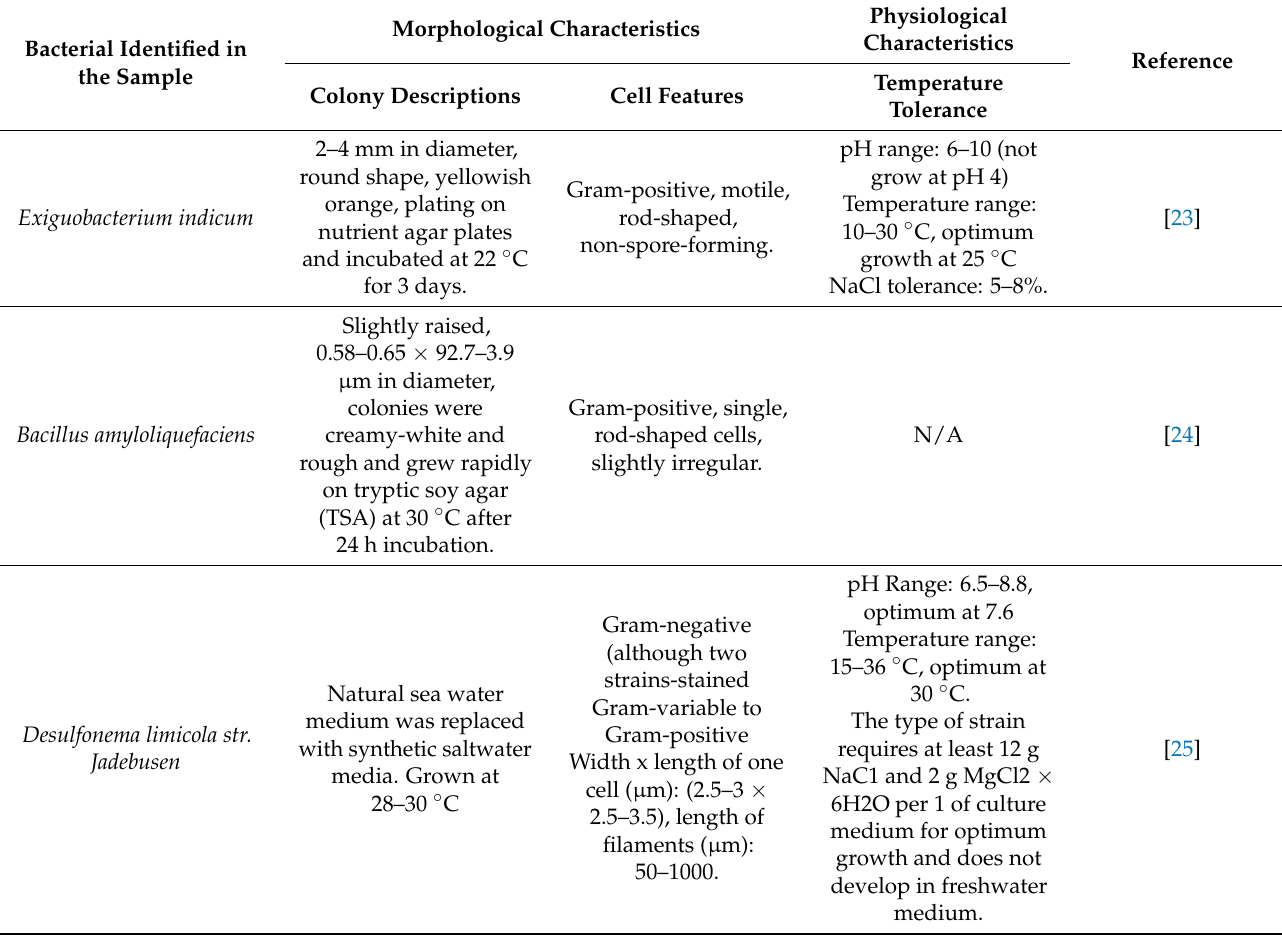
Table 3. Morphological and physiological characteristics of bacteria identified in the